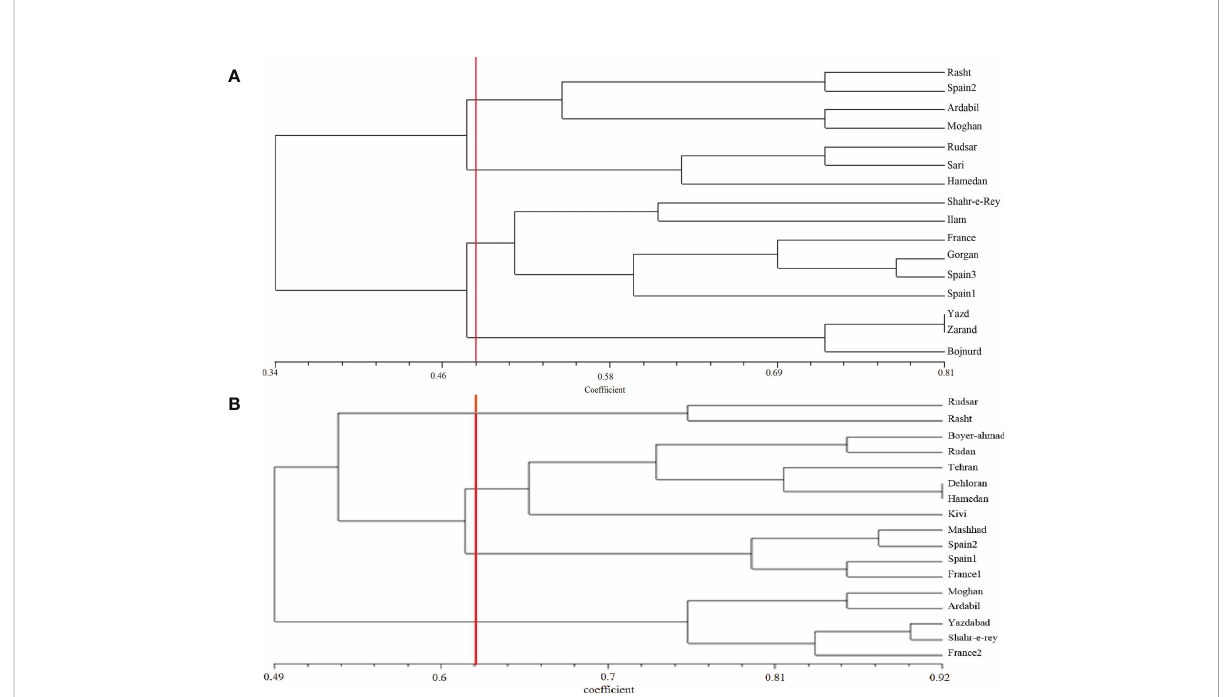
FIGURE 1 UPGMA clustering of A retro fl exus (A) and C album (B) populations based on Jaccard similarity coef fi cient calculated from ISSR